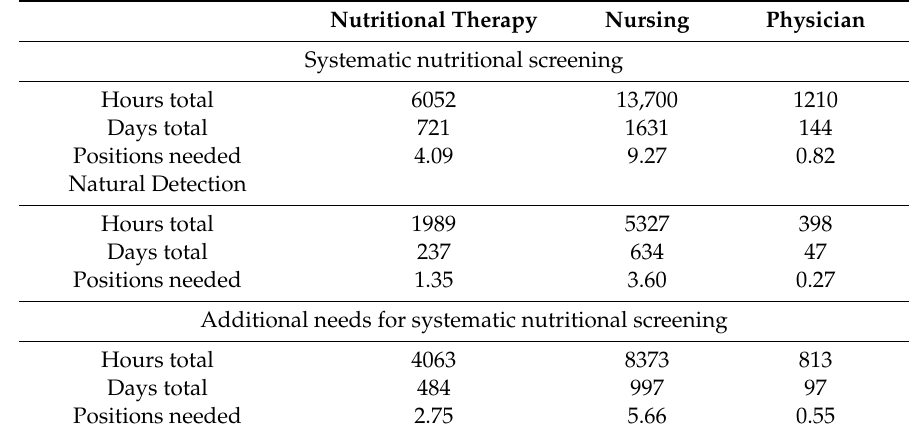
Table A3. Hours, workdays and positions needed for NI in the case of systematic NS, ND and additional needs for systematic NS.